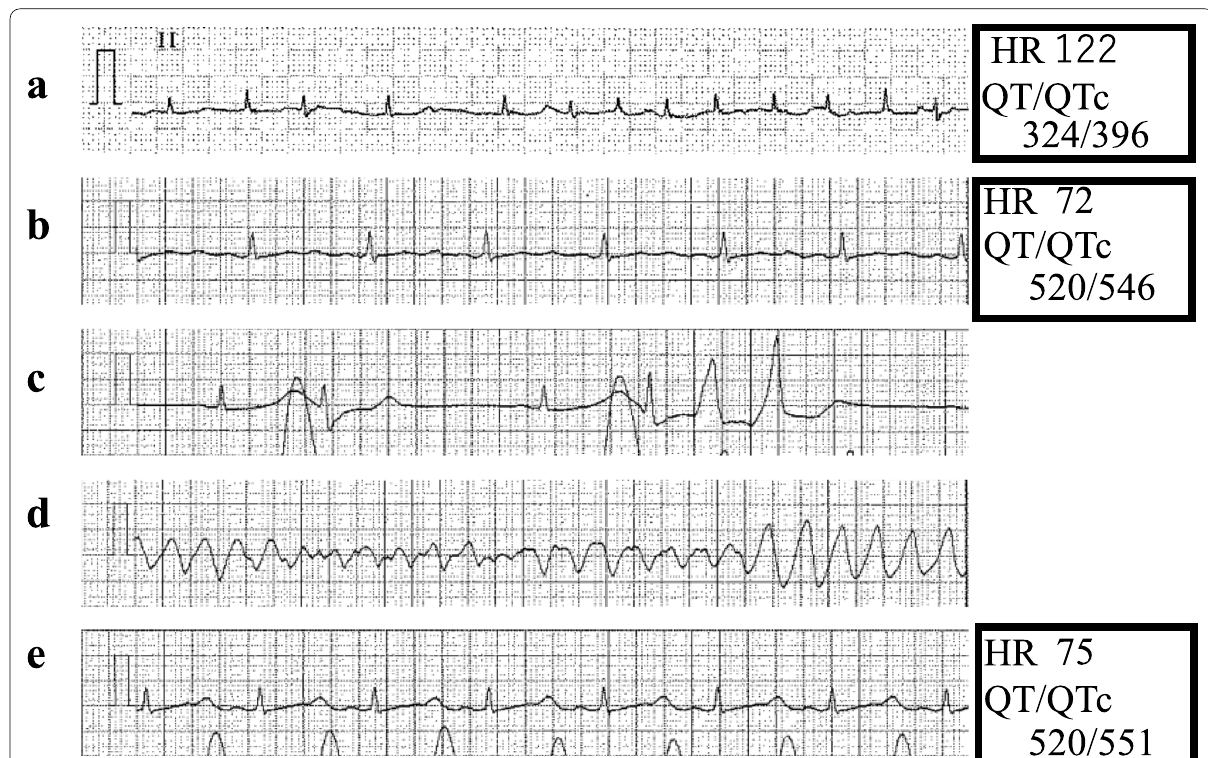
Fig. 1 Perioperative electrocardiographic changes. a One month before the operation: atrial fibrillation. b On admission to the operating room: sinus rhythm. c Eighteen min after the start of surgery: short runs of multifocal premature ventricular contractions (PVCs) are observed. d Twenty min after the start of surgery: torsades de pointes (TdP) lasting for 15 s. e After the start of isoproterenol: sinus rhythm: PVCs and TdP have